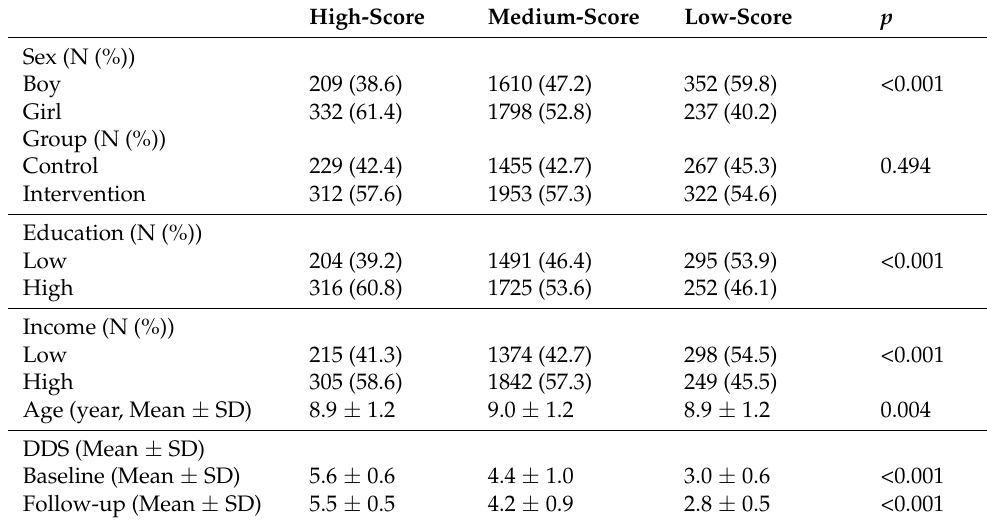
Table 1. Participant